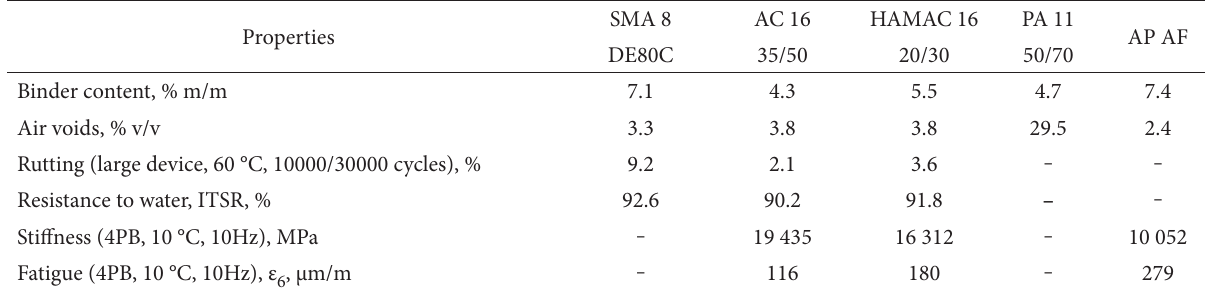
Table 1. Properties of bituminous mixtures designed for test